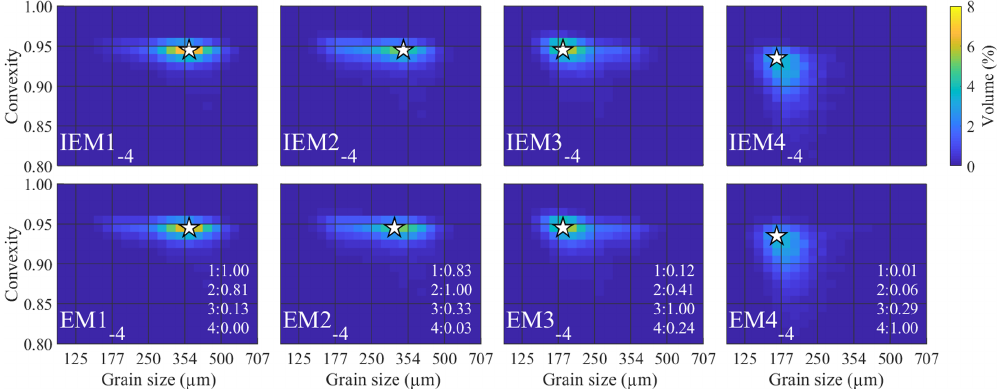
Figure 6. Endmembers determined for the ConD2d 4EM_noise dataset. Input endmembers (top) are compared to determined endmembers (bottom) including R 2 values. The first R 2 value indicates the correlation of the endmember with IEM1 − 4 , the second with IEM2 − 4 , etc. White stars mark the modes of the